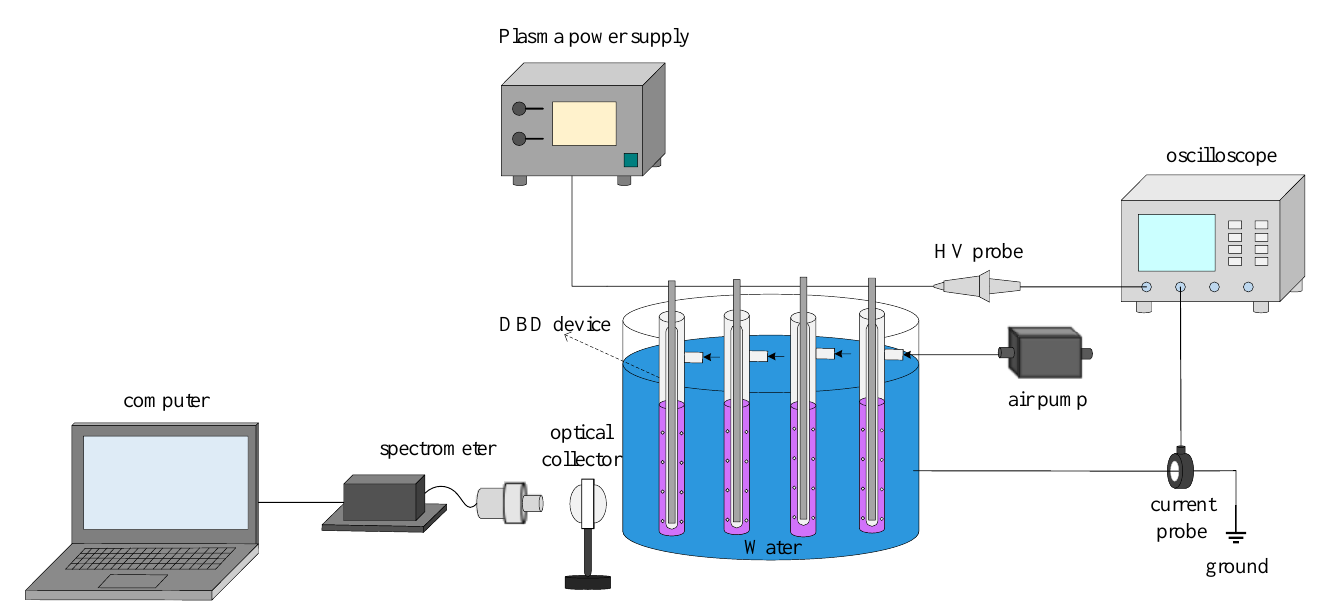
Figure 1. The overall structure diagram of the DBD-based PAW system.